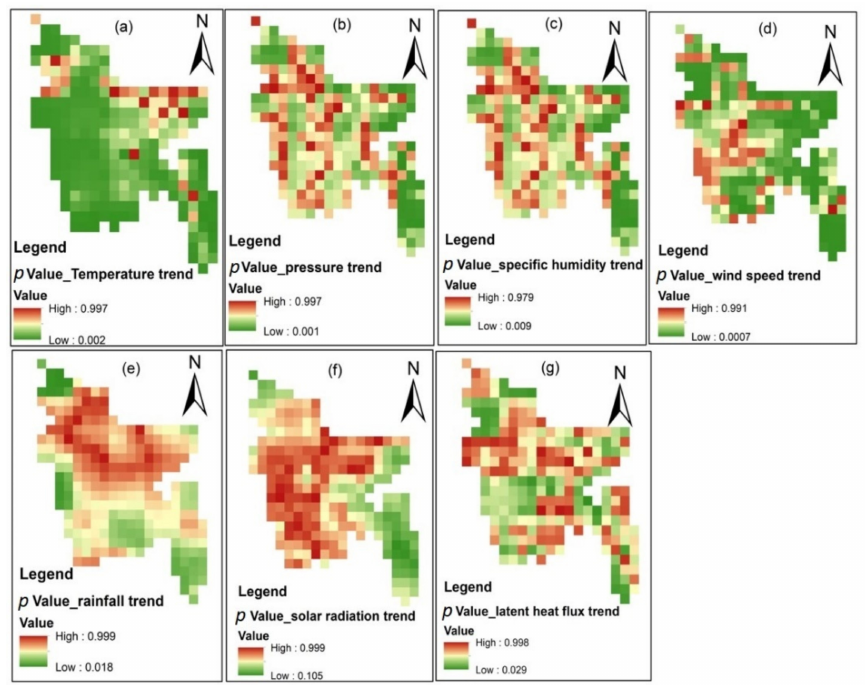
Figure 7. The p values for the trend analysis of meteorological parameters over Bangladesh in the period of 2015–2020: ( a ) temperature, ( b ) pressure, ( c ) specific humidity, ( d ) wind speed, ( e ) rainfall, ( f ) solar radiation, and ( g ) latent heat